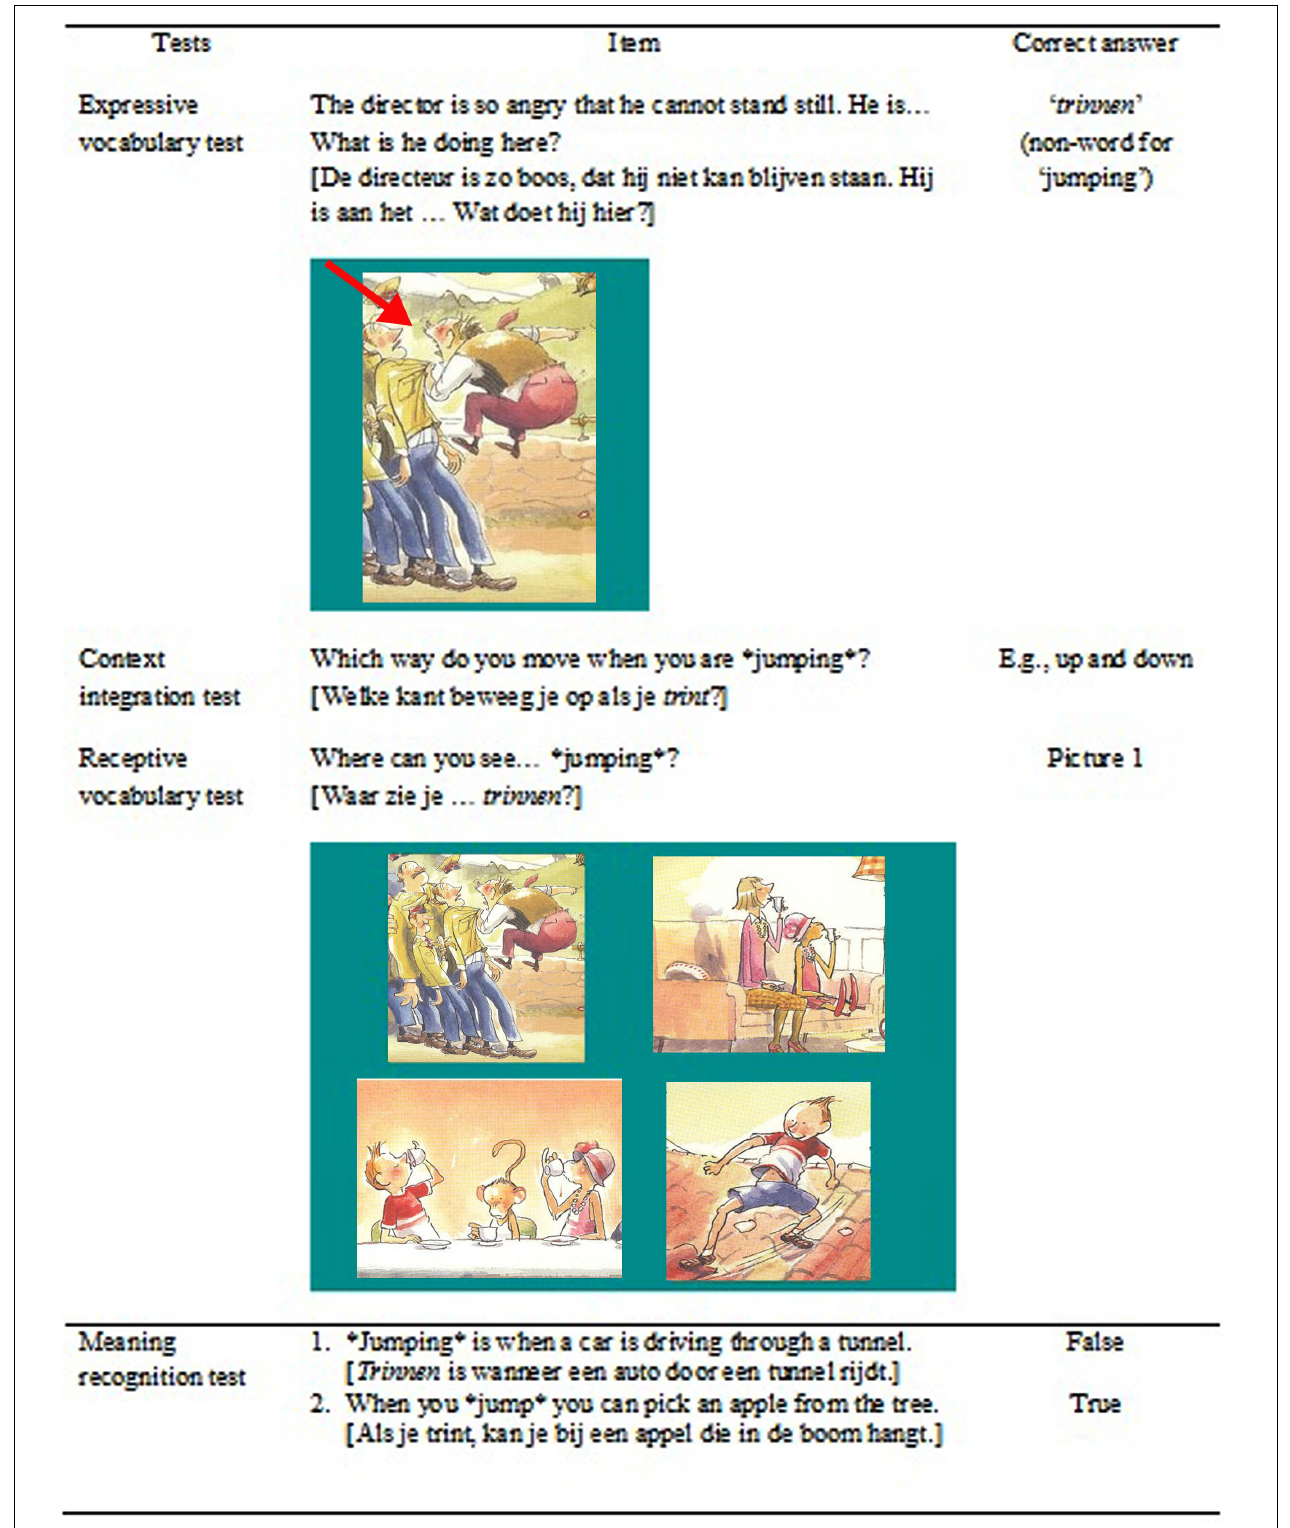
FIGURE 2 | Examples of the four vocabulary tests assessing knowledge of the non-word ‘trinnen’ which stands for the word ‘jumping’ including still frames from the animated version. Copyright 2014 by Het Woeste Woud.